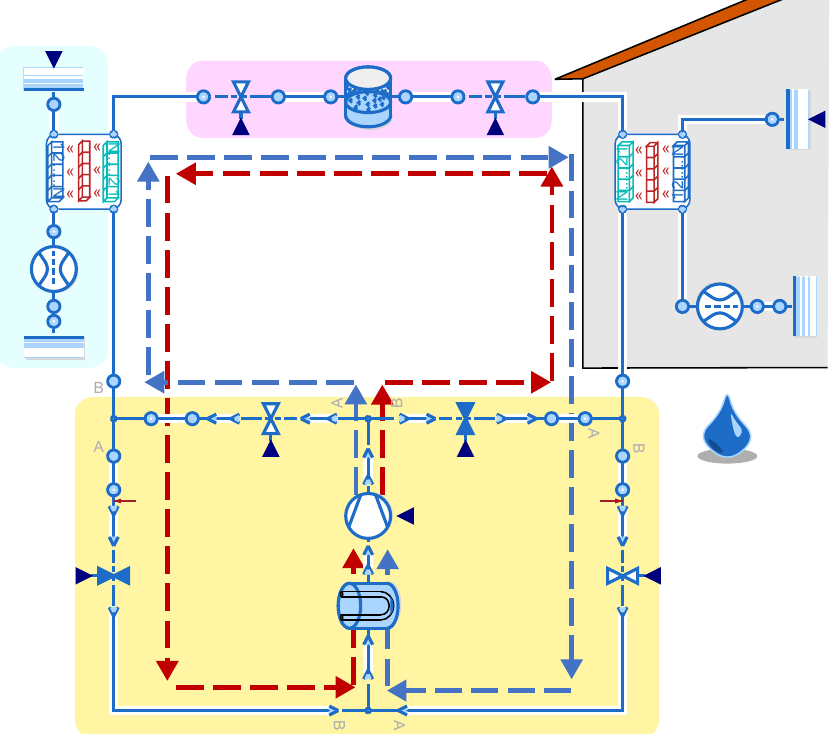
Figure 6. Example of a reversible heat pump that contains two undirected heat exchangers. The operating mode of the cycle can be switched during